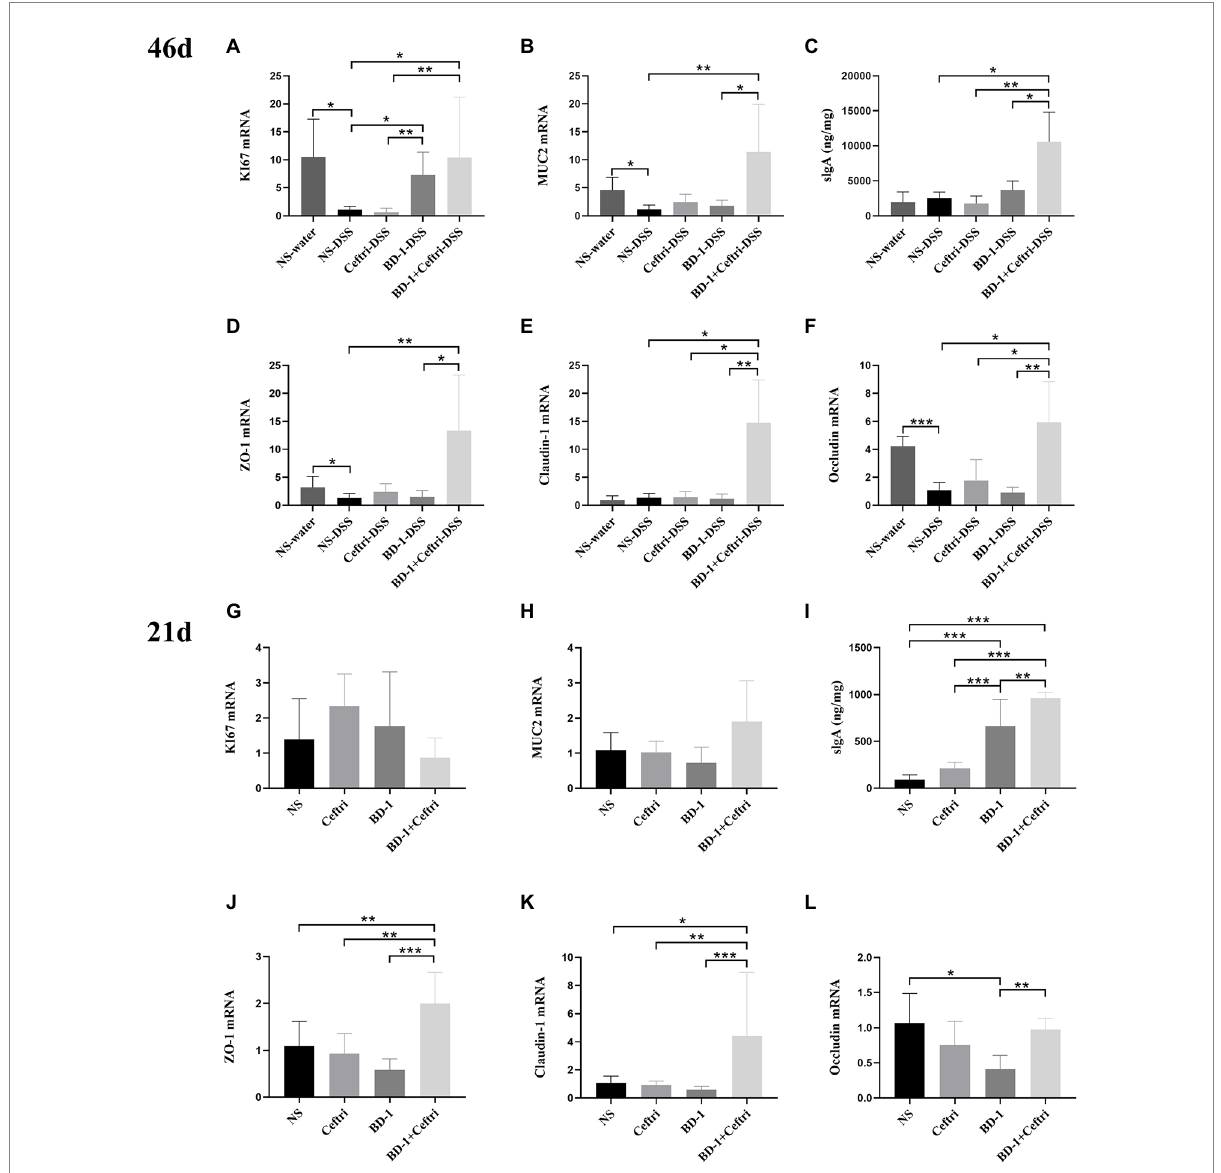
FIGURE 2 Colonic mucosal barrier condition after DSS induction and early life intervention (46 and 21 days, respectively; n = 6). (A–F) on day 46 and (G–L) on day 21. (A) Colonic KI67 mRNA level. (B) Colonic MUC2 mRNA level. (C) Secretory Immunoglobulin A (sIgA) level in the cecum faeces. (D) Colonic ZO-1 mRNA level. (E) Colonic Claudin-1 mRNA level. (F) Colonic Occludin mRNA level. (G) KI67 mRNA level. (H) MUC2 mRNA level. (I) SIgA level in the cecum faeces. (J) ZO-1 mRNA level. (K) Claudin-1 mRNA level. (L) Occludin mRNA level. * p < 0.05, ** p < 0.01, and *** p < 0.001 as